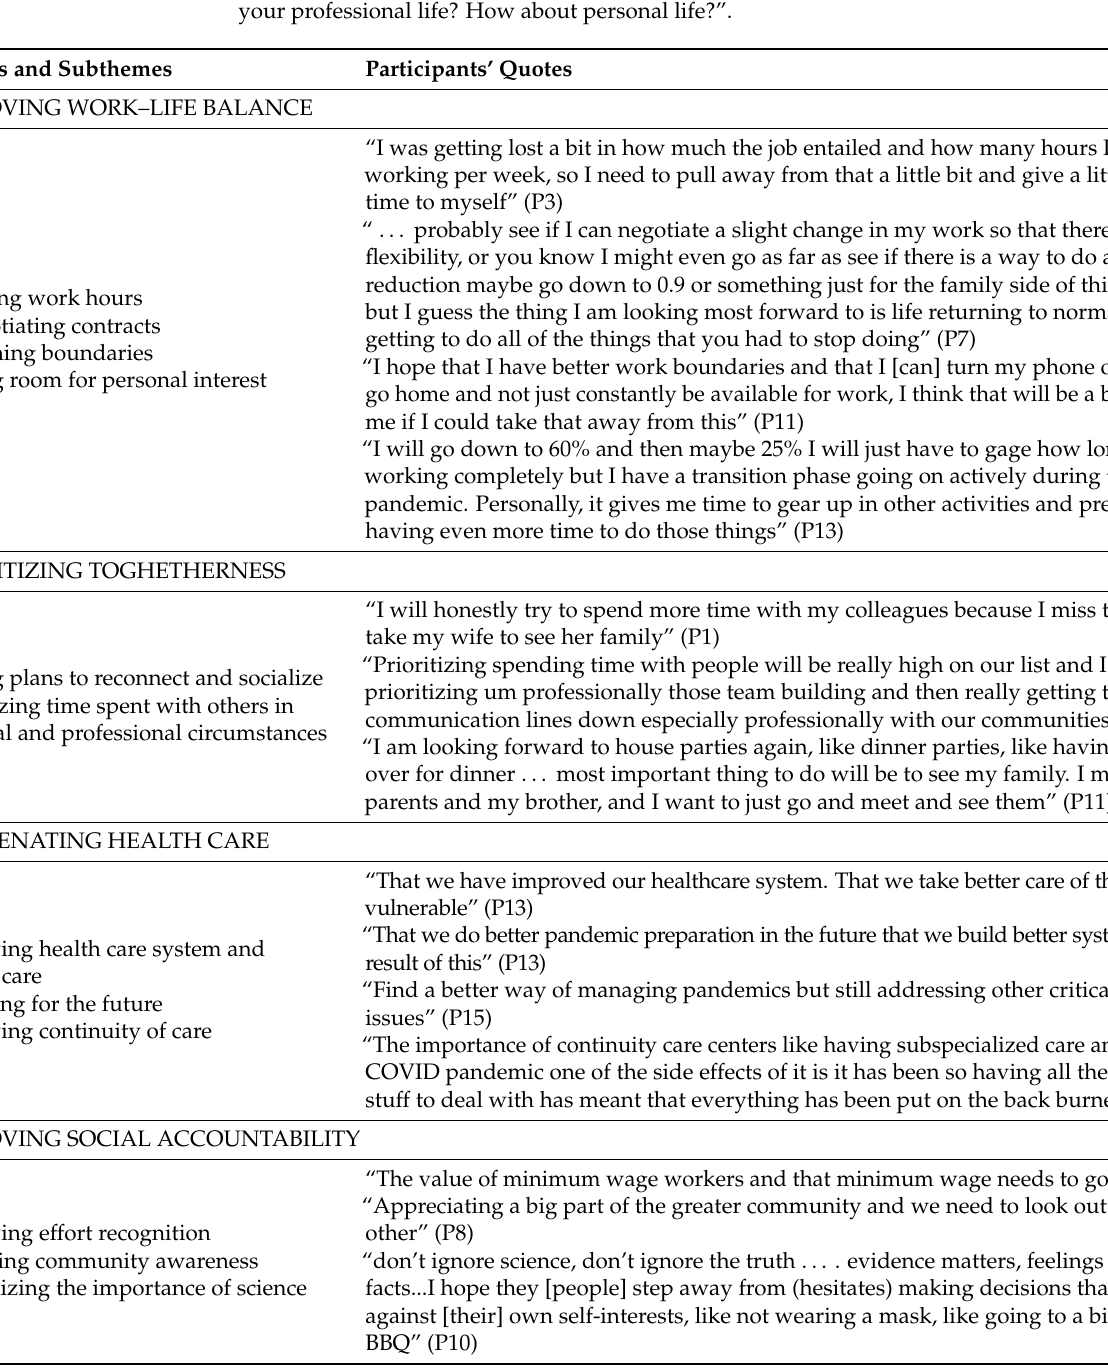
Table 5. Themes and subthemes highlighting the physicians’ perceived implications of the pandemic in response to the question, “what lessons are you learning from the COVID pandemic? Specifically, to your professional life? How about personal